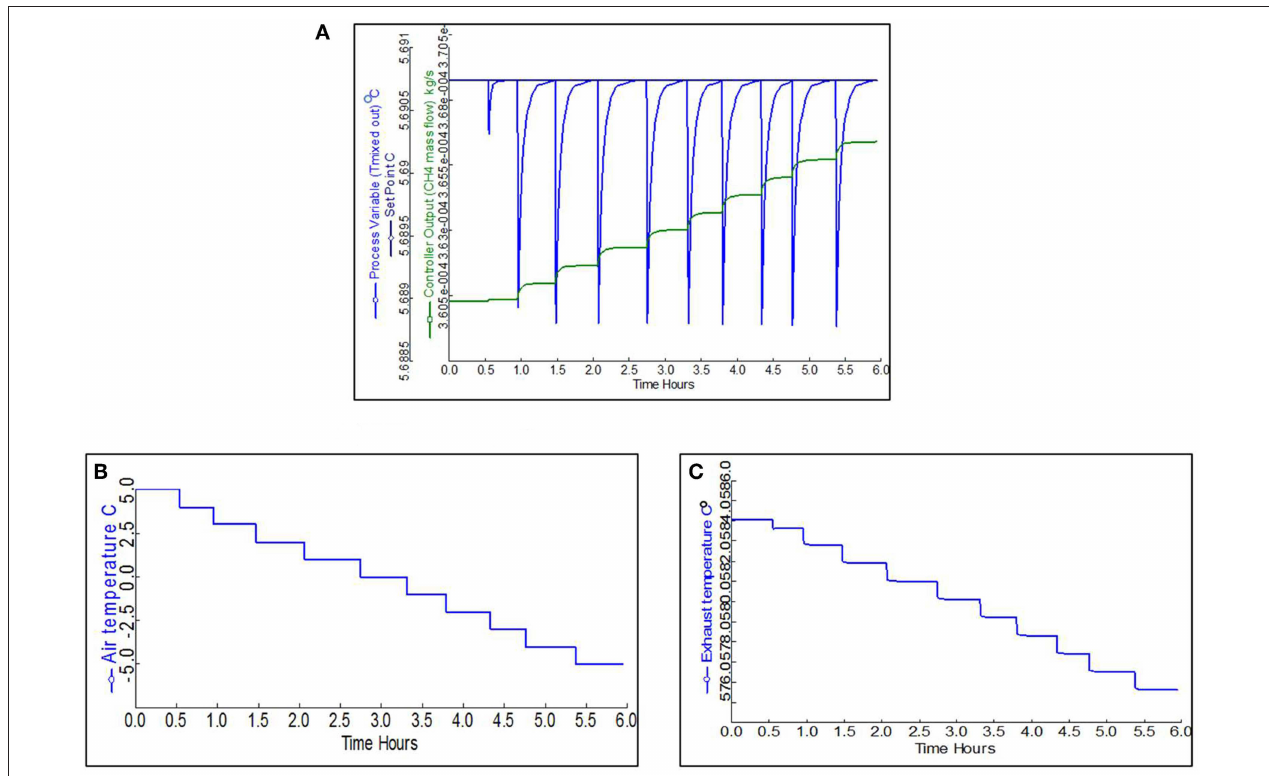
FIGURE 11 | Operating parameters in response to the changing ambient temperature. (A) 15 PID controller performance for ambient temperature range − 5 to 5 ◦ C. (B) The variation of the ambient air temperature over the time lapse. (C) The variation in burner exhaust temperature over the time lapse.